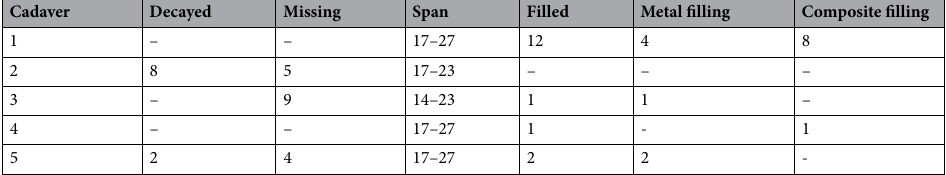
Table 1. Dental status of the cadavers. The DMFT status is complemented with span of the dental arch (most distal element in both quadrants) and type of filling.